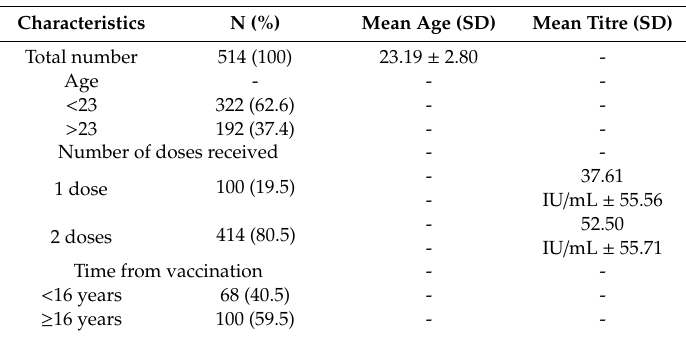
Table 1. Main population